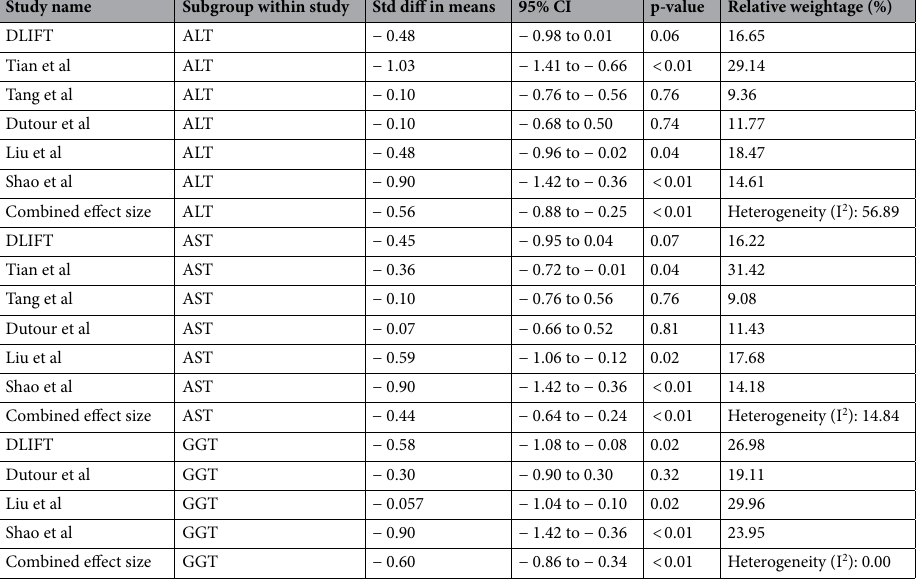
Table 2. Effect of GLP1-RA versus control on markers of hepatic inflammation: (a) ALT, (b) AST, and (c) GGT. CI confidence interval.